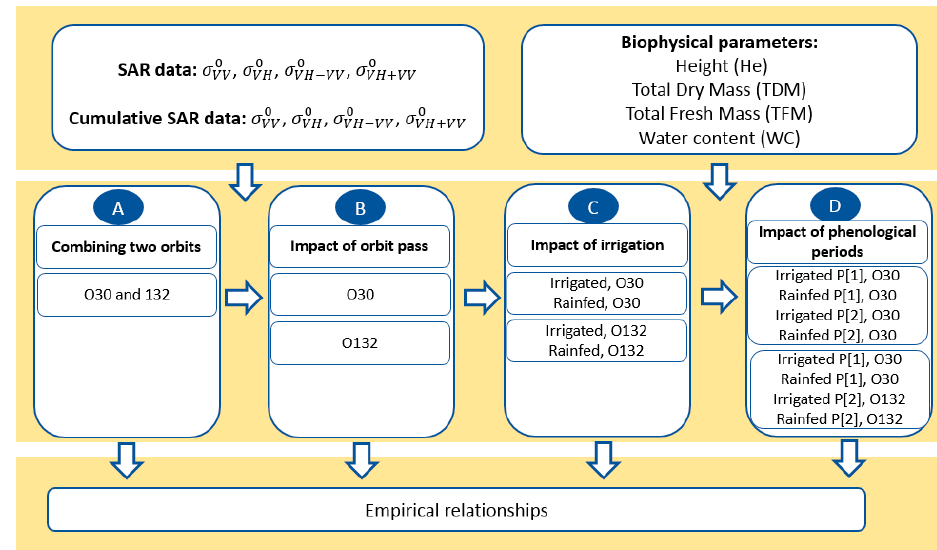
Figure 6. Methodological flowchart used to identify the best synthetic aperture radar (SAR) configuration as a function of wheat parameters (He, TDM, TFM and WC). O30 and O132 represent the two orbits 30 and 132 respectively. P [1] and P [2] are the two considered vegetative periods.